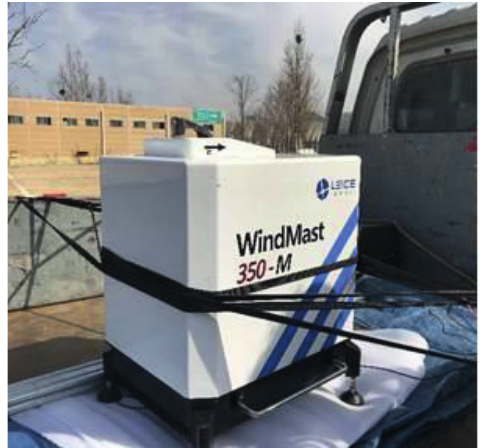
Figure 2. Floating Lidar System - WindMast 350-M